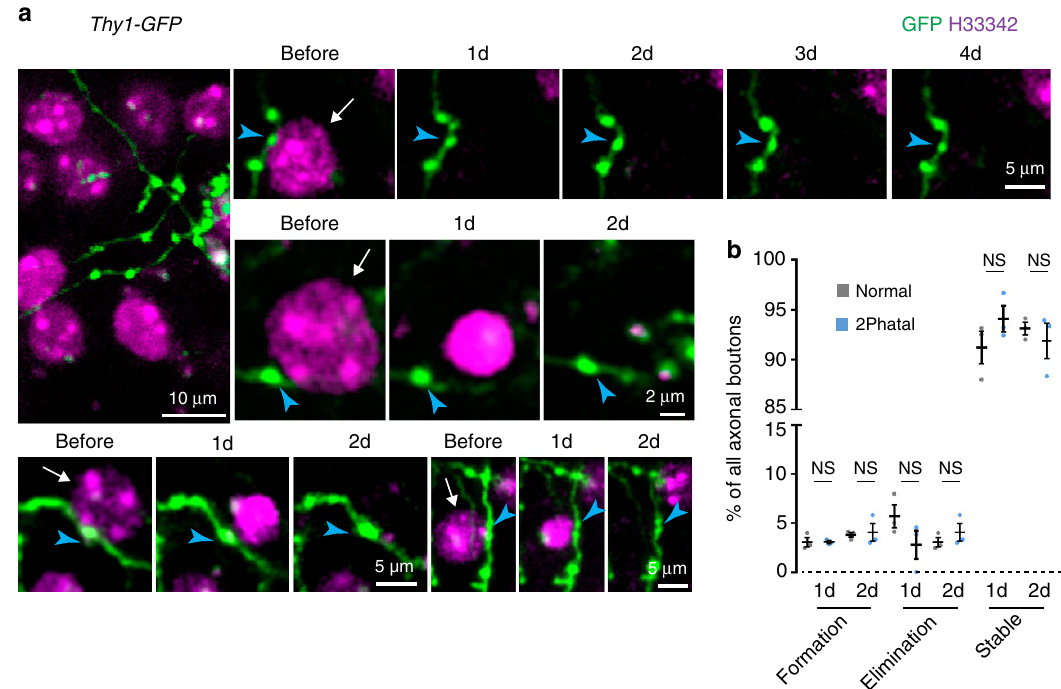
Figure 3 | 2Phatal does not cause collateral damage to immediately adjacent neural structures. ( a ) In vivo images showing GFP-labelled axonal boutons adjacent to H33342-labelled nuclei targeted for ablation with 2Phatal (arrows). During nuclear pyknosis, no significant changes in immediately adjacent boutons (blue arrowheads) was detected. ( b ) No differences in axonal bouton plasticity adjacent to normal or 2Phatal ablated cells over 2 days; 42 cells for each condition from n ¼ 3 mice, t -test, control vs 2Phatal, formation: 1d P ¼ 0.981, t ¼ 0.0249, df ¼ 4; 2d P ¼ 0.960, t ¼ 0.2706, df ¼ 4; elimination: 1d P ¼ 0.721, t ¼ 1.5700, df ¼ 4; 2 d P ¼ 0.854, t ¼ 0.9813, df ¼ 4; stable 1d P ¼ 0.744, t ¼ 1.3843, df ¼ 4; 2d P ¼ 0.907, t ¼ 0.6567, df ¼ 4 (df ¼ degrees of